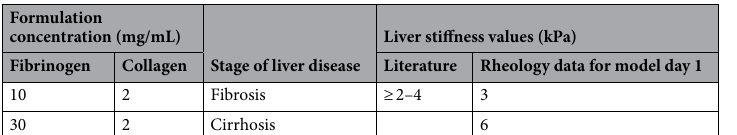
Formulation concentration